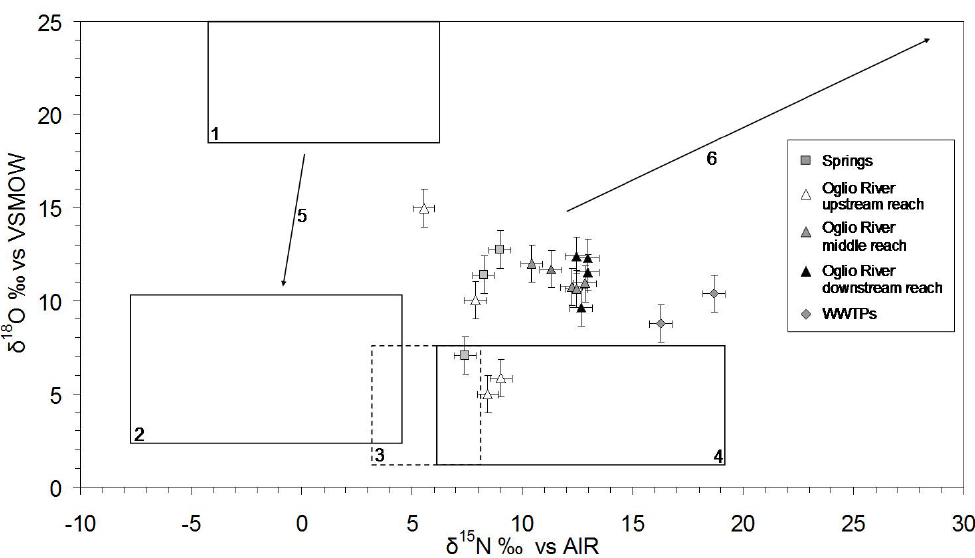
Fig. 6. Isotopic composition of nitrate in water from the Oglio River (white triangles=upstream reach; grey triangles=middle reach; black triangles=downstream reach), springs (squares) and selected WWTPs (diamonds). Compositional fields: 1 – synthetic fertilizers; 2 – nitrified synthetic fertilizers; 3 – soil organic matter and contamination from mixed sources; 4 – anthropogenic organic matter (sewage and manure); 5 – evolution during nitrification; 6 – evolution during denitrification. Modified after Kendall (1998), and Clark and Fritz